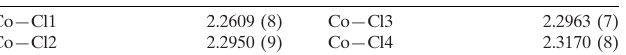
Selected bond lengths (A˚ ).